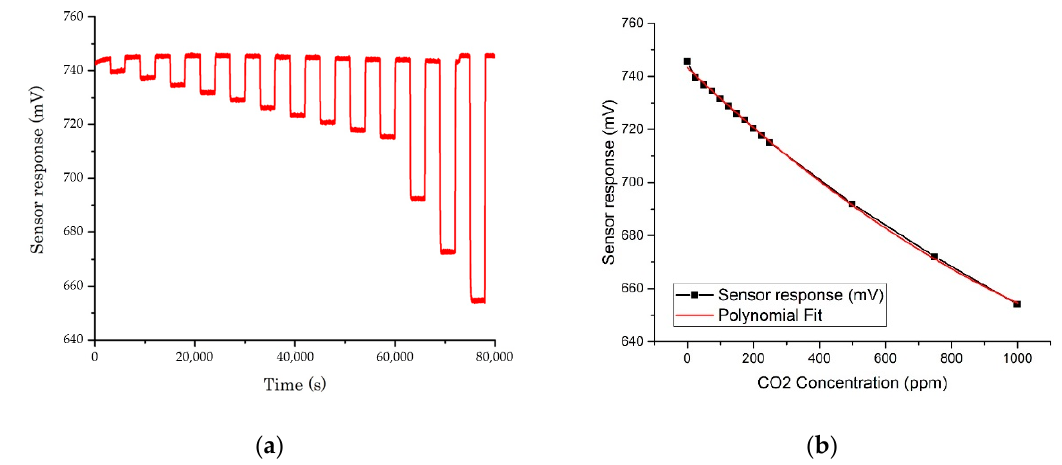
Figure 9. Sensor response to CO 2 gas with different concentrations, from 25 to 1000 ppm, at 4.2 µm: ( a ) sensor response; and ( b ) polynomial fit (R-Square = 0.999).